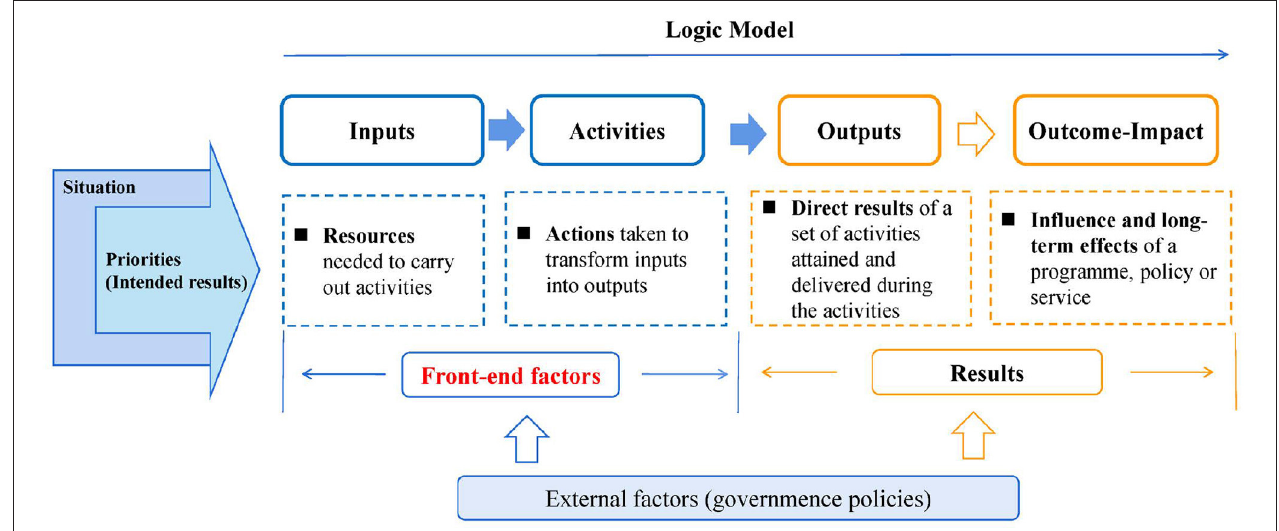
FIGURE 1 | Elements of a results